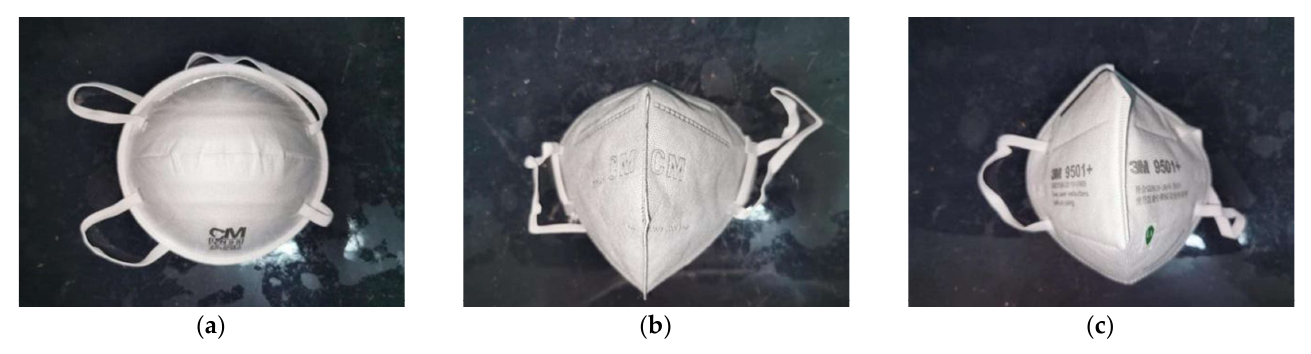
Figure 1. The three typical KN95 disposable facepiece respirators: ( a ) CM 8228-1 cup-shaped KN95, ( b ) CM 6002A head-mounted KN95, ( c ) 3M 9501+ folding KN95.